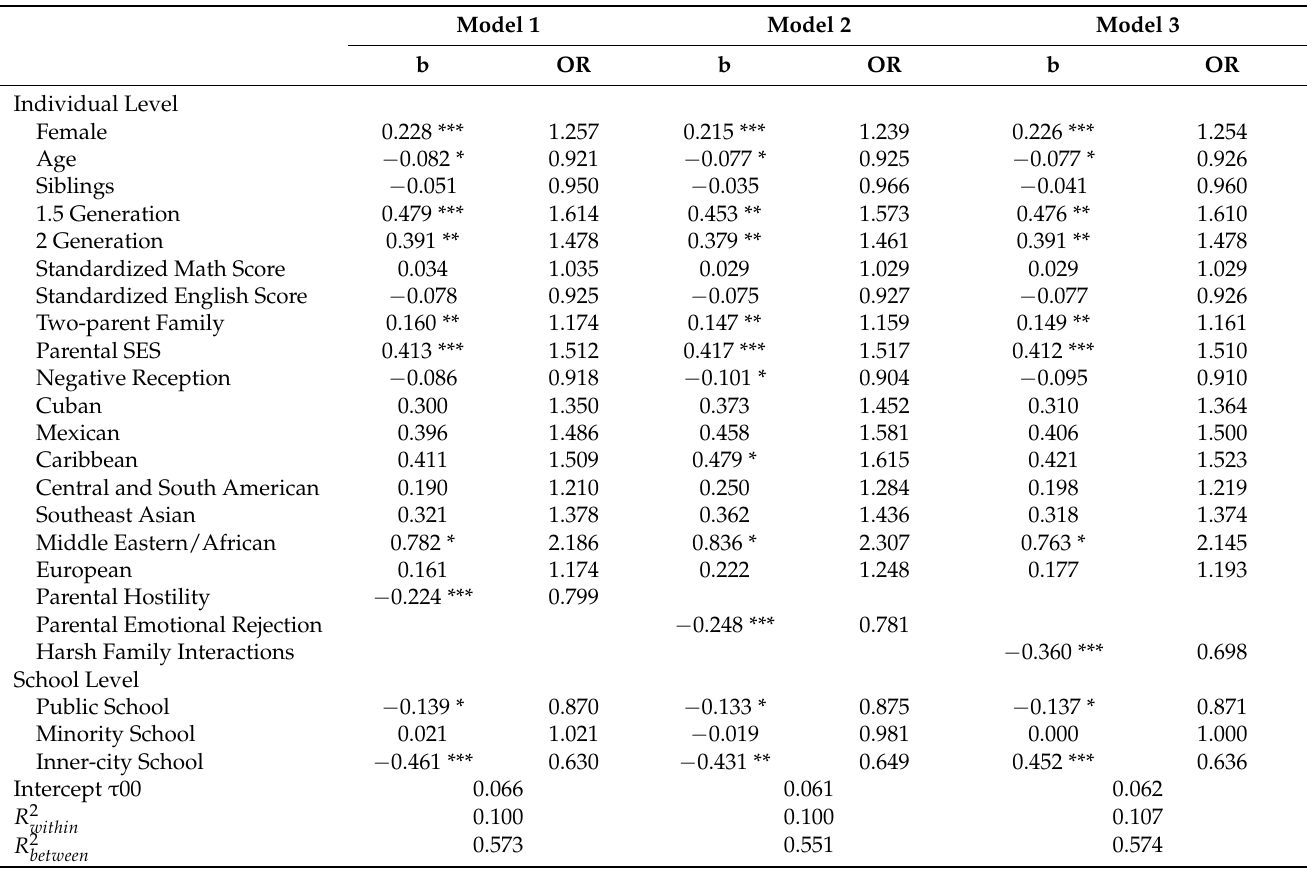
Table 2. Generalized linear mixed modeling predicting the effects of parental hostility, emotional rejection, and harsh family interactions with parents in early adolescence of immigrant youths on their successful college graduation in young adulthood. Model 1 Model 2 Model